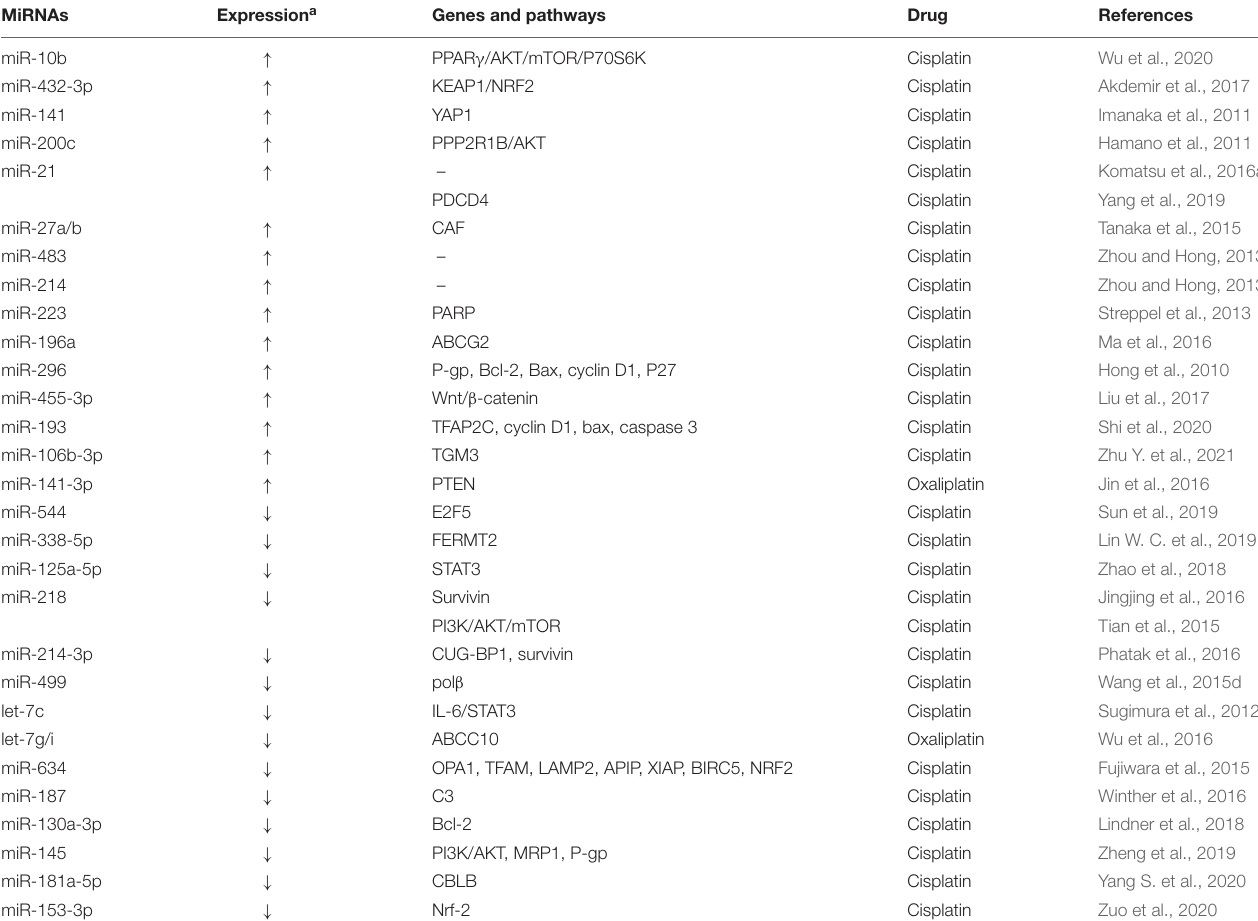
TABLE 1 | MicroRNAs (miRNAs) and platinum drugs resistance in esophageal cancer. MiRNAs Expression a Genes and pathways